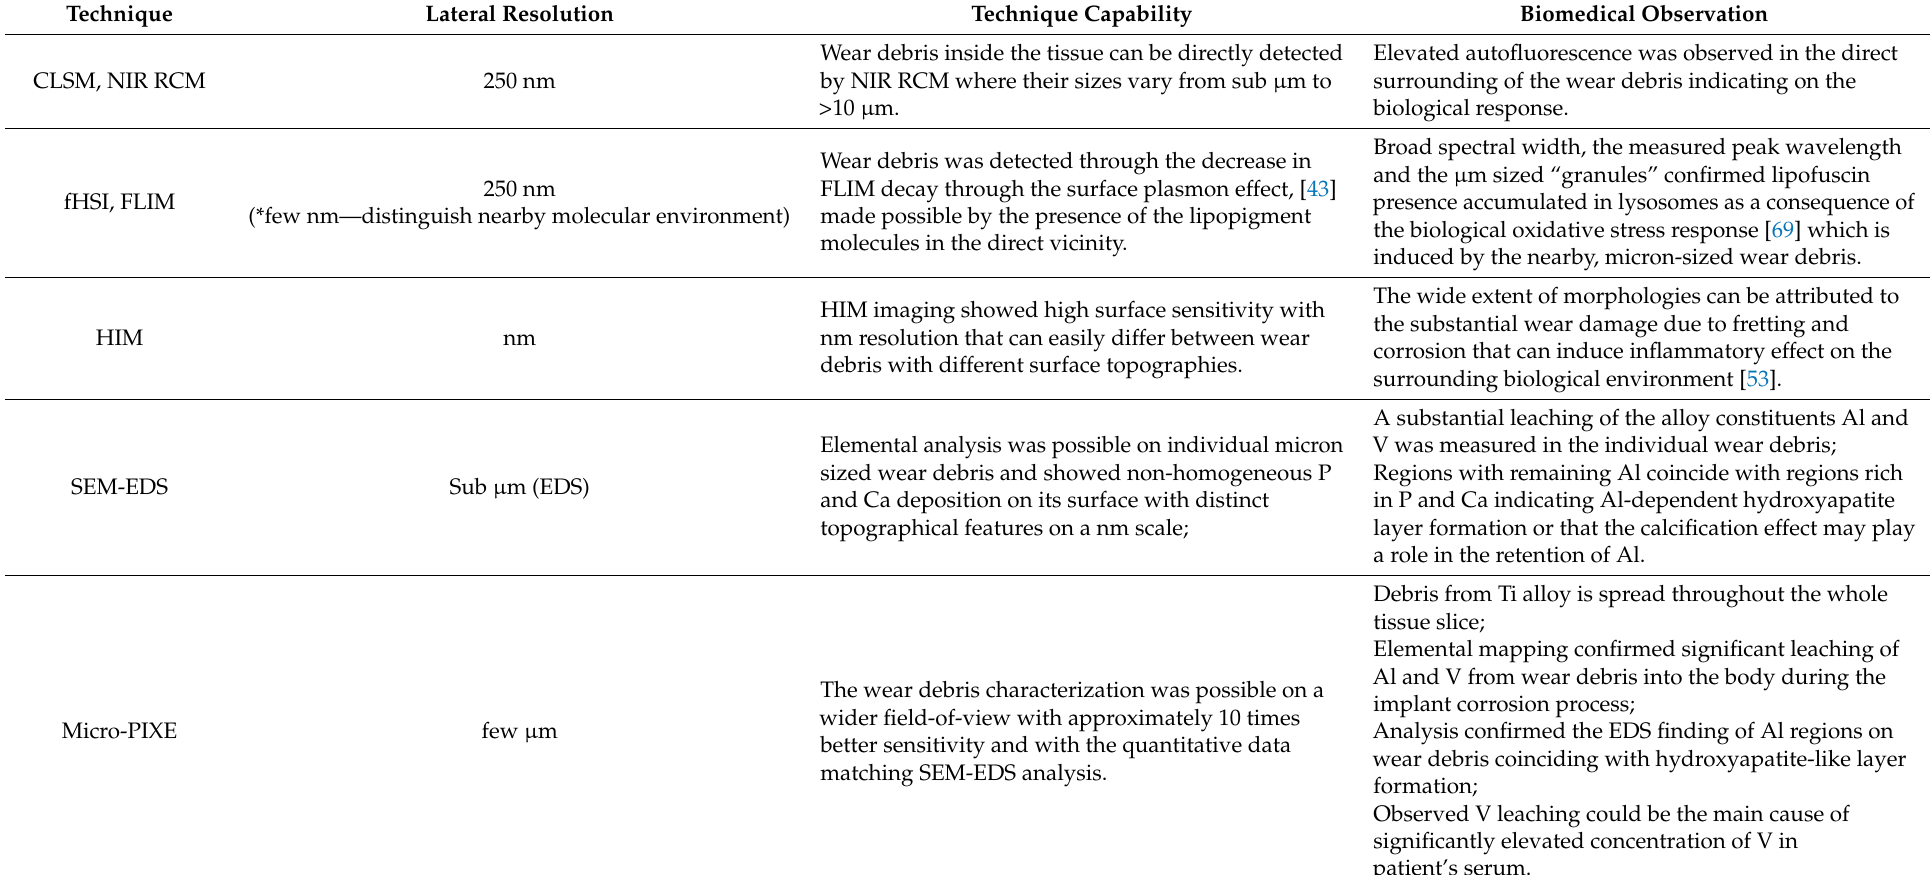
Table 2. Overview of the key findings of the wear debris in the periprosthetic tissue by advanced complementary experimental